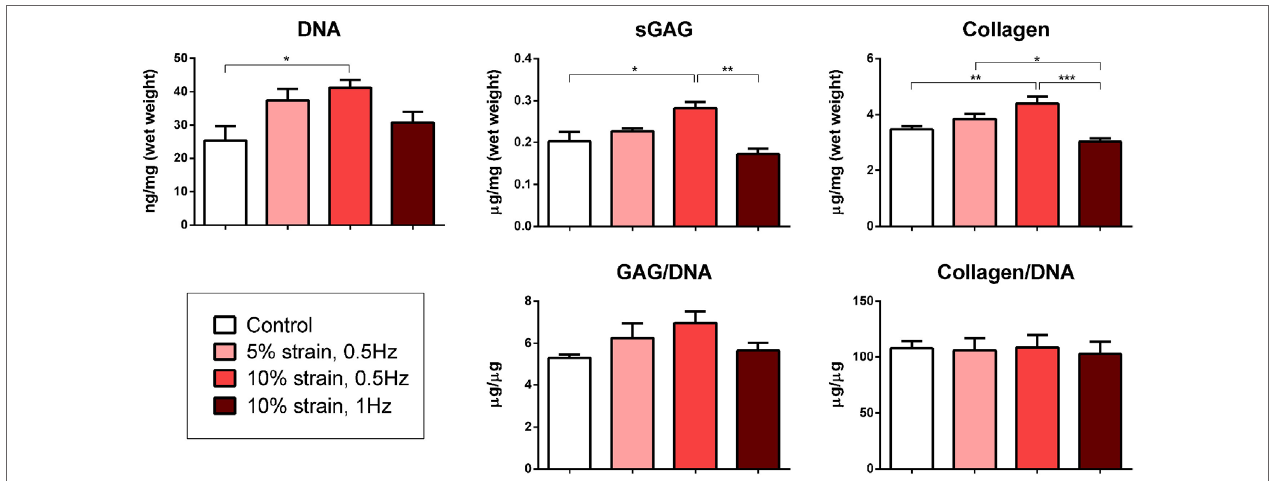
FigUre 3 | Biochemical analysis of multipotent stromal cell encapsulated fibrin hydrogels cultured in tensile strain bioreactors in media supplemented with chondrogenic growth factor transforming growth factor- β 3 for 21 days. The application of 10% cyclic tensile strain at 0.5 Hz was found to promote cellular proliferation, which led to an increase in total cartilage matrix deposition. Significant differences are indicated where present (* p < 0.05; ** p < 0.01; *** p < 0.001; n =